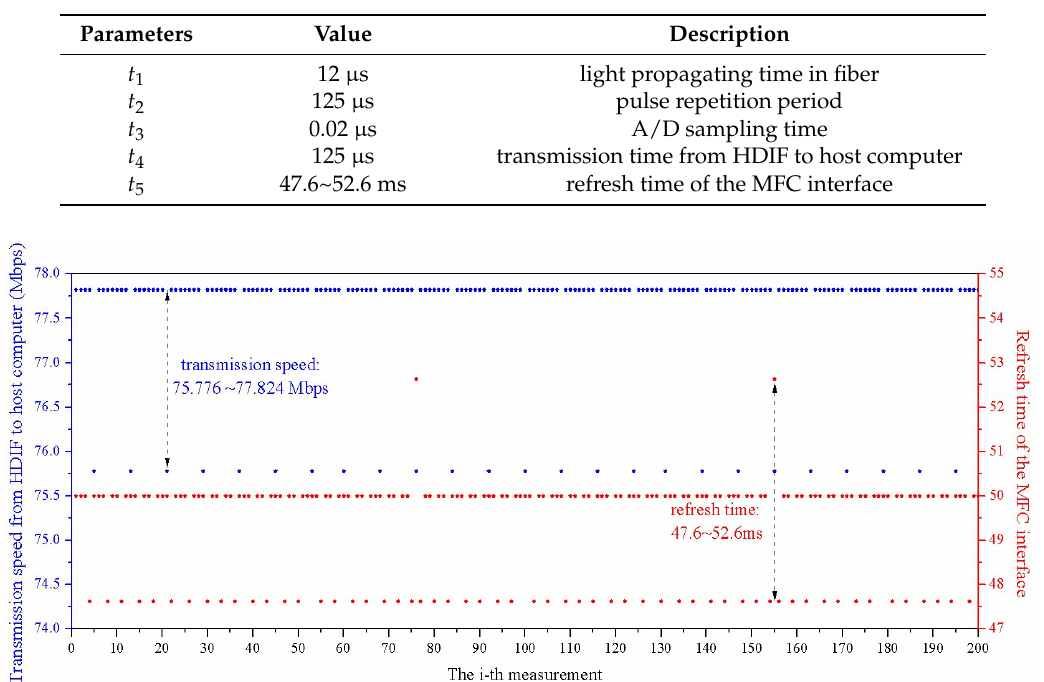
Table 1. Summary of the times.